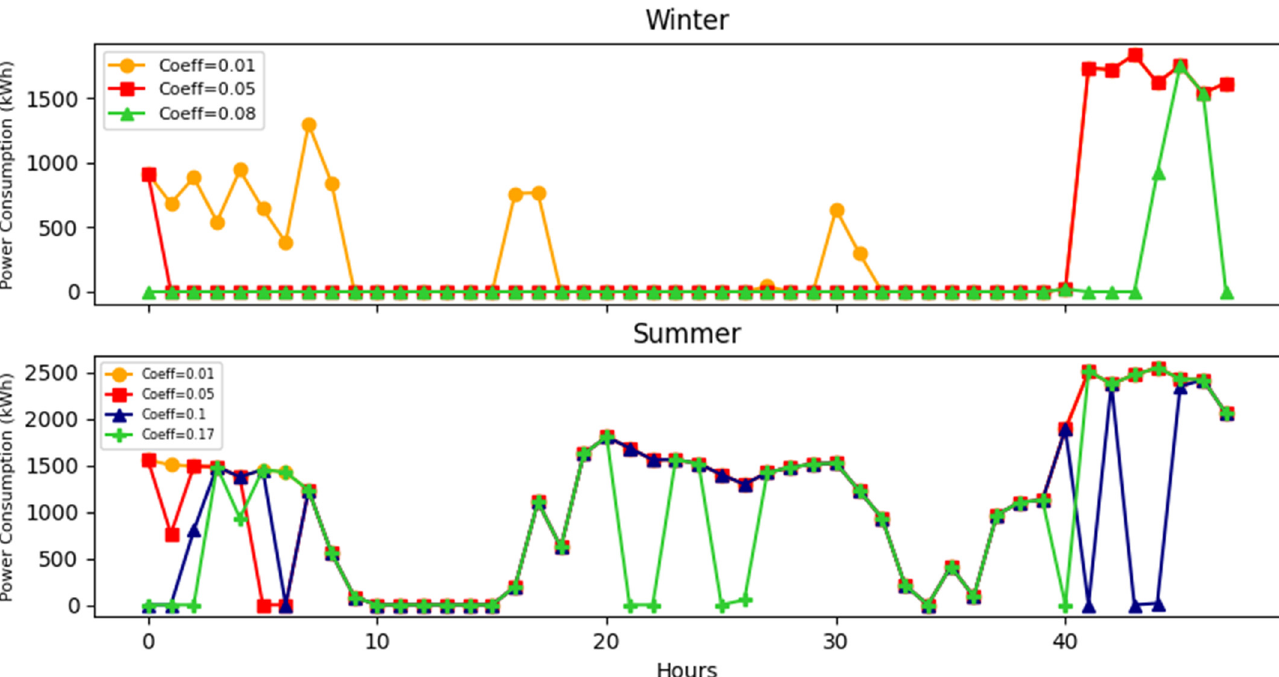
Figure 2. Trial and error results for finding the best coefficient.